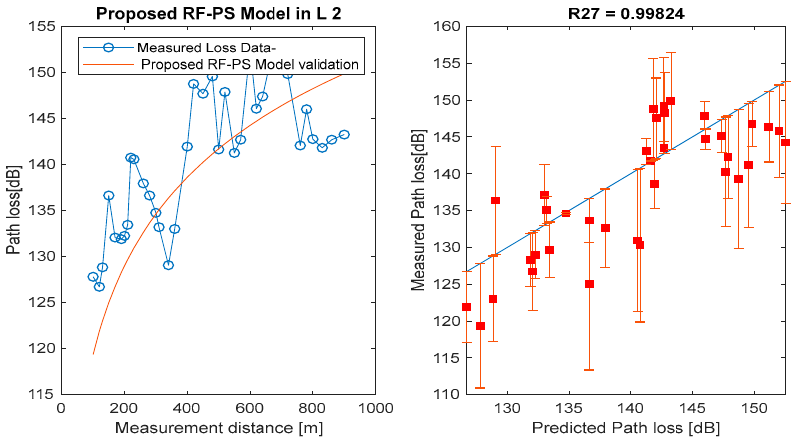
Figure 33. Measured path loss and the proposed hybrid RF-PS model validation plot using another site in location 2.